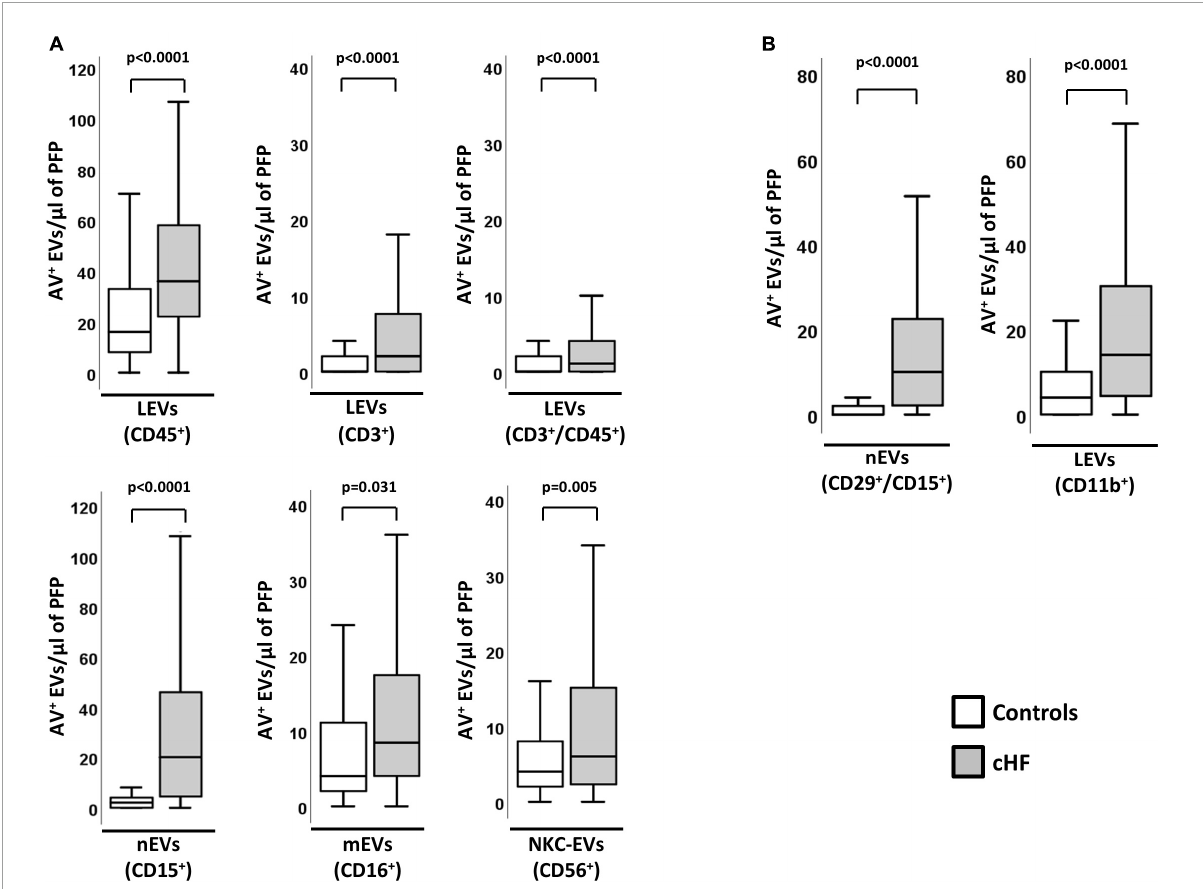
FIGURE1 Cellular origin and distribution of AV + EVs in cHF and controls. (A) Distribution of EVs from total leukocytes (CD45 + ), T-lymphocytes (CD3 + and CD3 + /CD45 + ), neutrophils (CD15 + ), monocyte/macrophage (CD16 + ) and natural-killer cells (CD56 + ). (B) Distribution of EVs from activated neutrophils (CD29 + /CD15 + ) and from activated leukocytes (CD11b + ). A p < 0.05 was considered significant (U Mann–Whitney test). AV + , annexin V + ; cHF, chronic heart failure; EVs, extracellular microvesicles; LEVs, leukocyte-derived EVs; lEVs, lymphocyte-derived EVs; mEVs, monocyte-derived EVs; nEVs, neutrophil-derived EVs; NKC-EVs, natural-killer cells-derived EVs; PFP, platelet-free